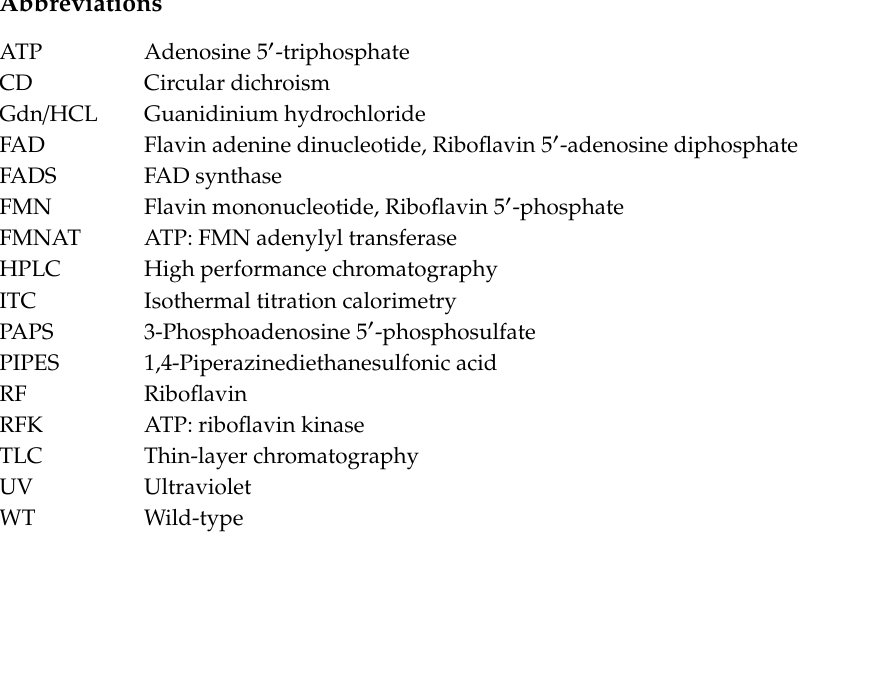
Figure S1: Conformation of Ca FADS mutants, Figure S2: Kinetic parameters for the FMNAT and RFK activities of the Ca FADS variants, Figure S3: Internalization of the isoalloxazine ring of FMN in Ca FADS variants, Figure S4: Internalization of the isoalloxazine ring of FAD in Ca FADS variants, Figure S5: Binding a ffi nity of ligands to WT and F128K Ca FADS variants, Figure S6: Quaternary assembly of Ca FADS (PDB 2x0k), Table S1: Extinction coe ffi cients for the Ca FADS variants, Table S2: Thermodynamic parameters for the interaction of Ca FADS variants with flavin and adenine